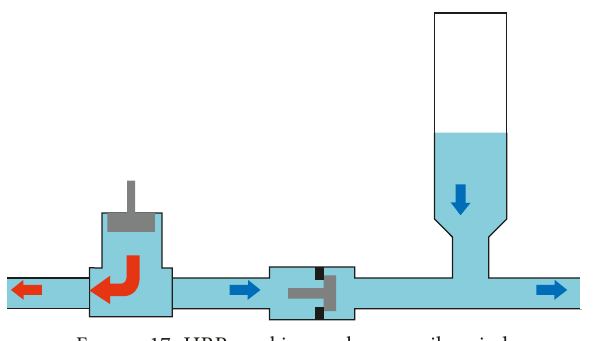
Figure 17: HRP working cycle: a recoil period.